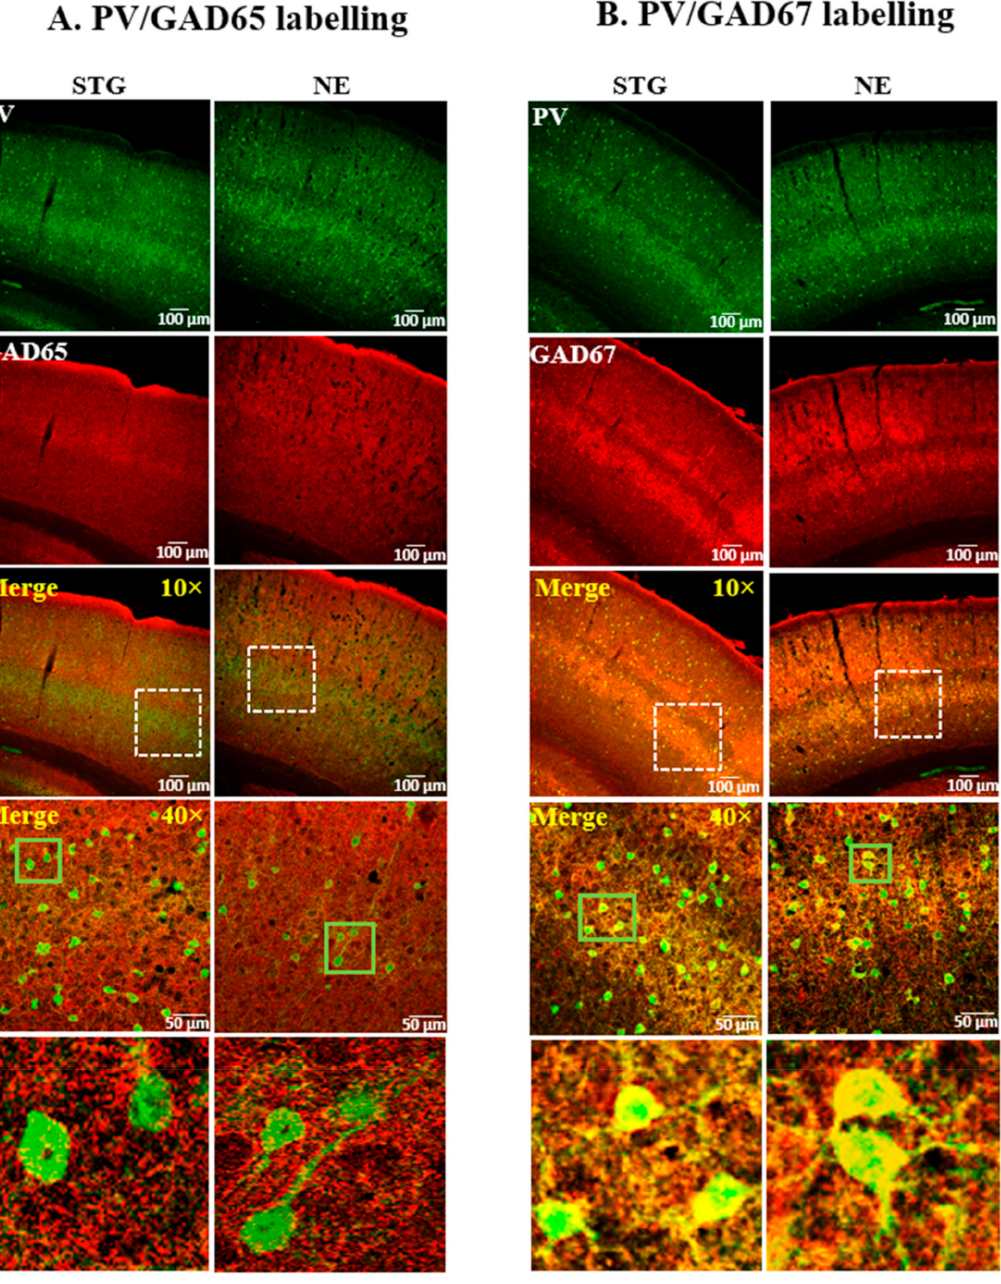
Figure 1. Representative confocal images showing the expression of ( A ) GAD65 or ( B ) GAD67, and PV in the SScortex of epileptic stargazers (STG) and non-epileptic littermates (NE). Merged images at low magnification (10 × ) and medium magni- fication (40 × ) are shown. White dotted boxes in the third panel were magnified in the fourth panel. Green boxes in the fourth panel were magnified in the bottom panels of figures ( A , B ) to show punctate structures and colocalisation,